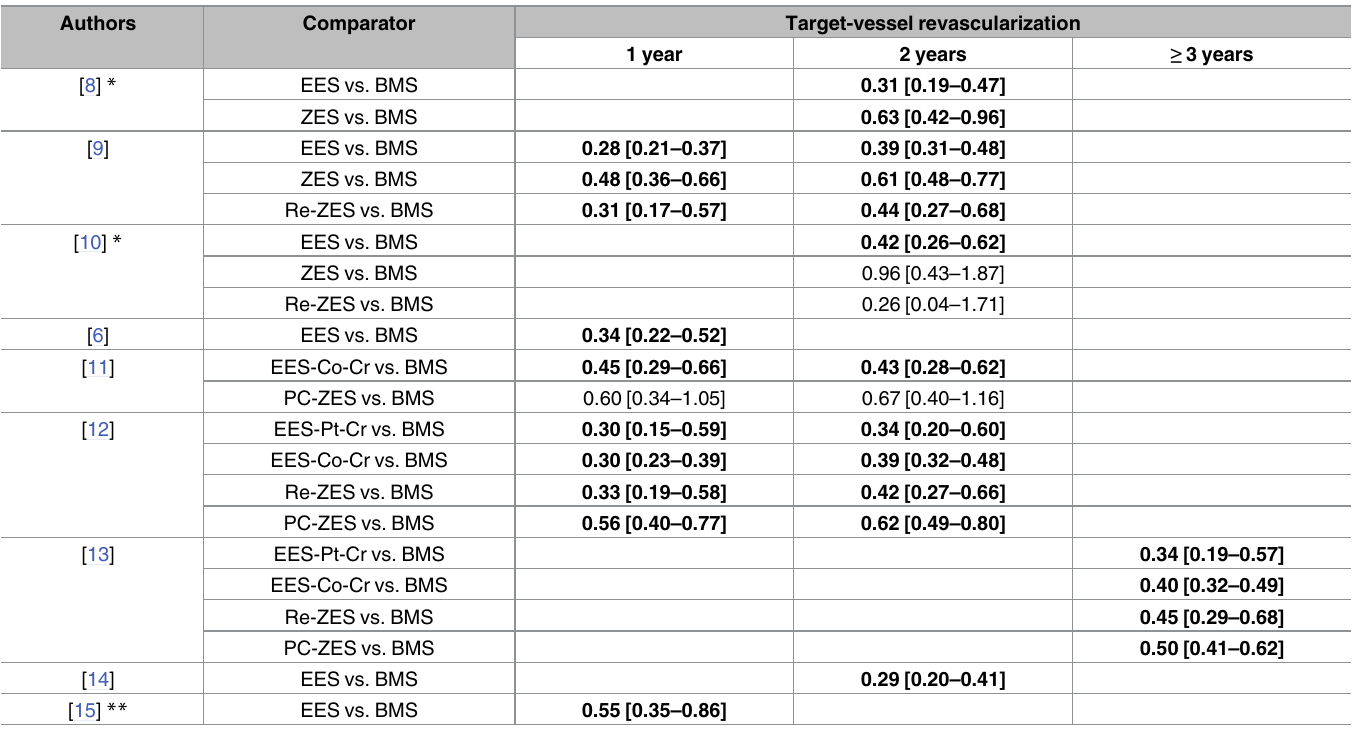
Table 2. Rate ratio of target-vessel revascularization